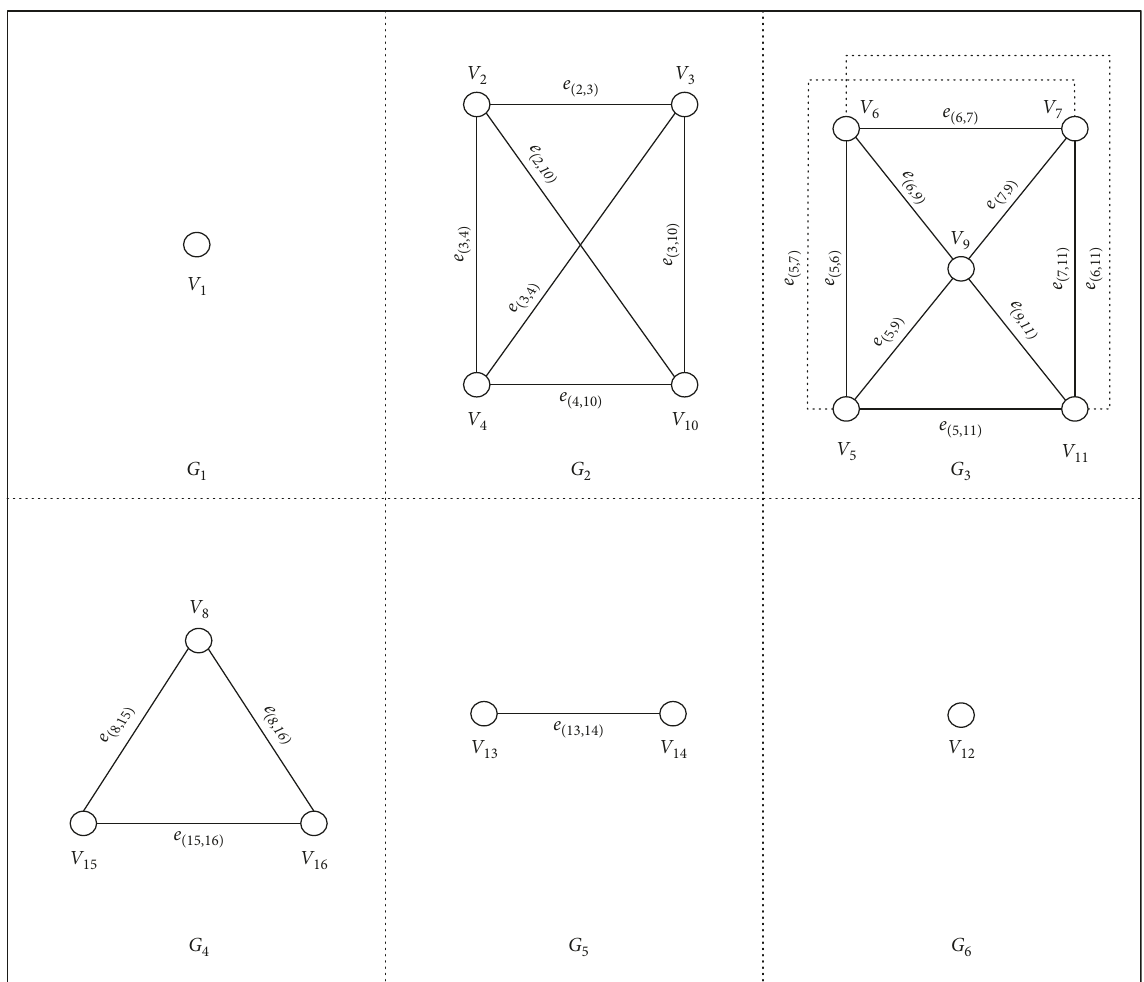
Figure 2: Index classification.